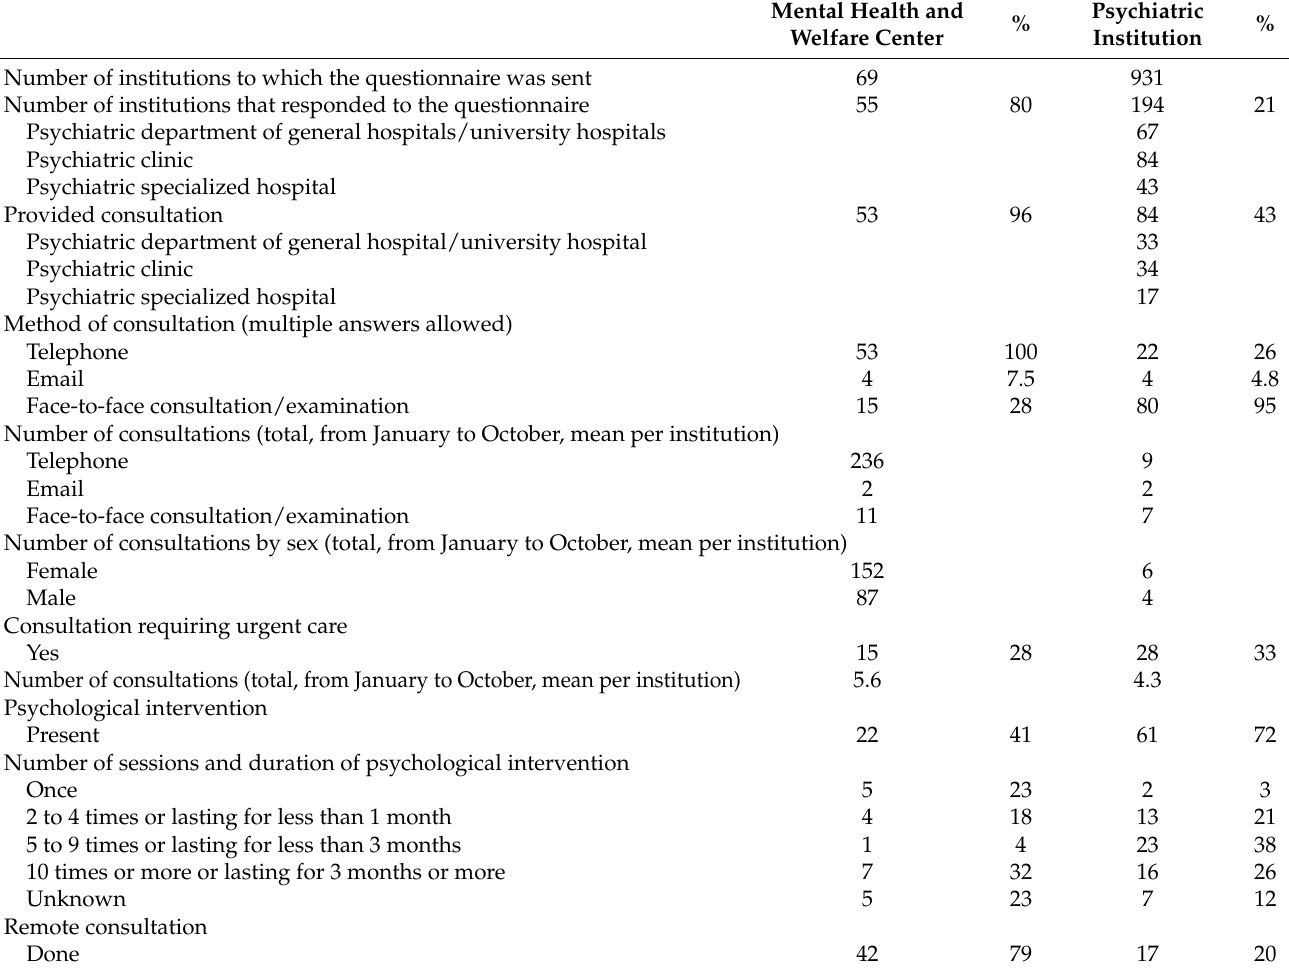
Table 1. Outlines of the results of the questionnaire